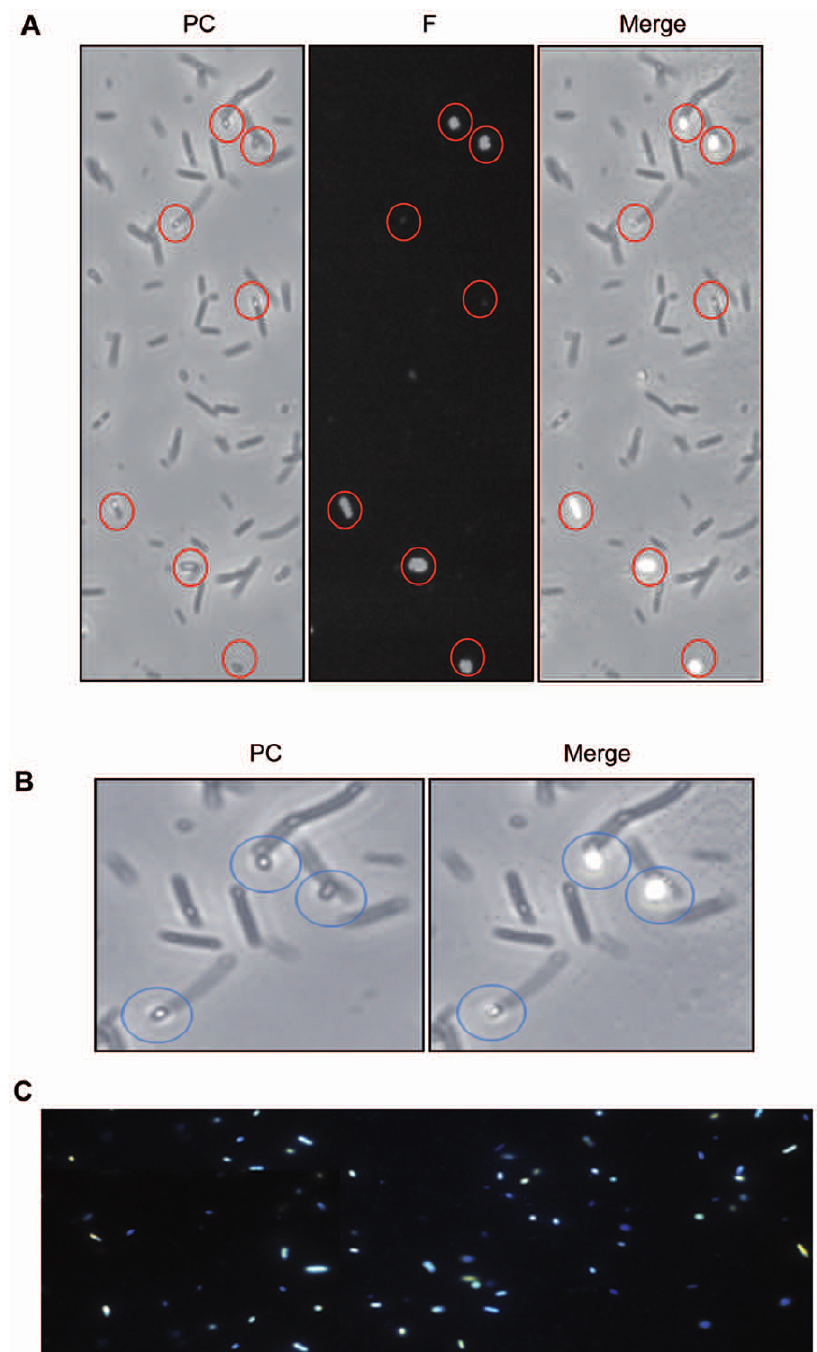
Figure 3. Fluorescence microscopy of E.coli exposed to Cd and Te salts. E. coli AG1/pCA24N gshA treated with CdCl 2 and K 2 TeO 3 was analyzed by epifluorescence microscopy. Circles indicate structures where fluorescence is accumulated. A, left image: phase contrast (PC); central image: monochromatic fluorescence (F) after excitation using UV-DAPI/FITC filter; right image: merge. B, left image: magnification phase contrast (PC); left image: merge. C, fluorescence microscopy under UV light exposure.